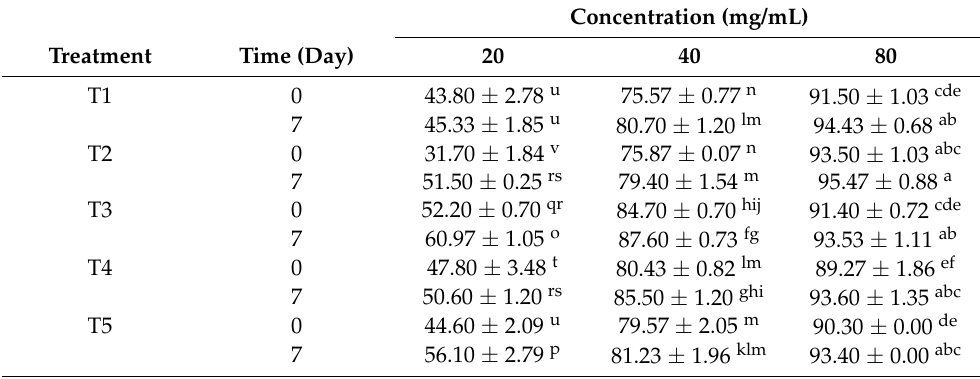
Table 2. Antioxidant activity as a percentage of DPPH radical inhibition by peptide extracts from fermented milk samples obtained just after fermentation (day 0) and after 7 days of storage. Concentration (mg/mL) Treatment Time